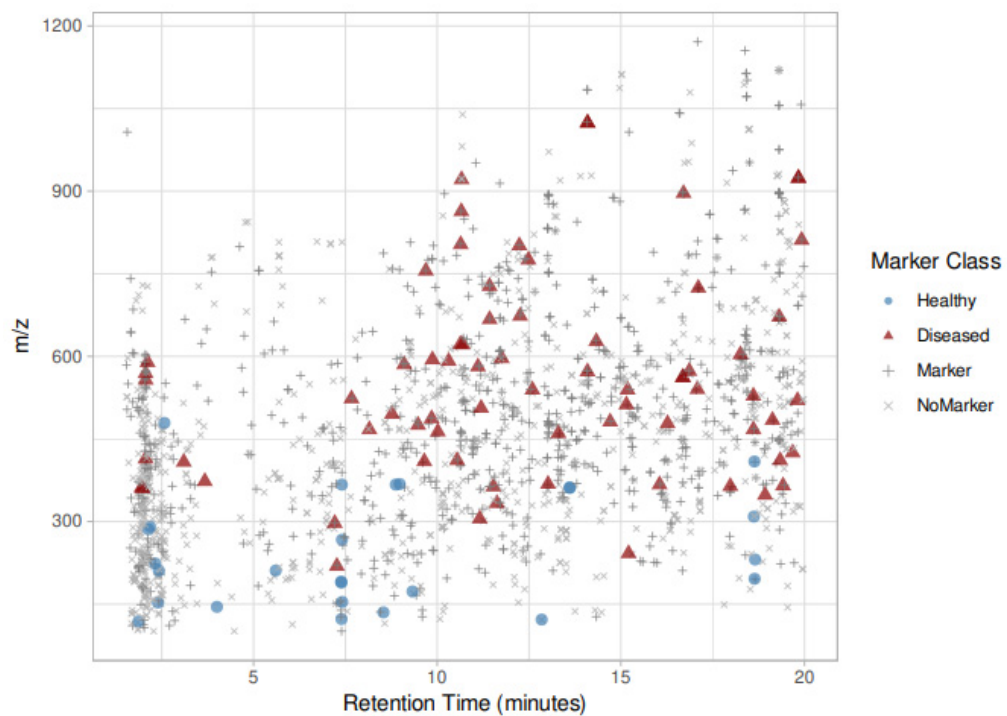
Figure 2. Two-dimensional map of features discovered, visually separated for their retention time ( x -axis) and their m / z ratio ( y -axis); blue and red colored dots represent, respectively, healthy and diseased state markers (77 and 26).